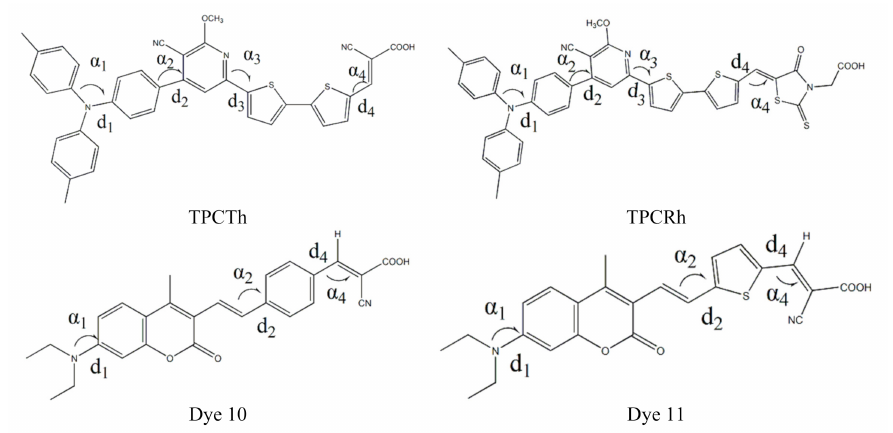
Figure 1. Chemical structures of the four original molecules Triphenylamine dyes (TPCTh, TPCRh), 10 and 11.